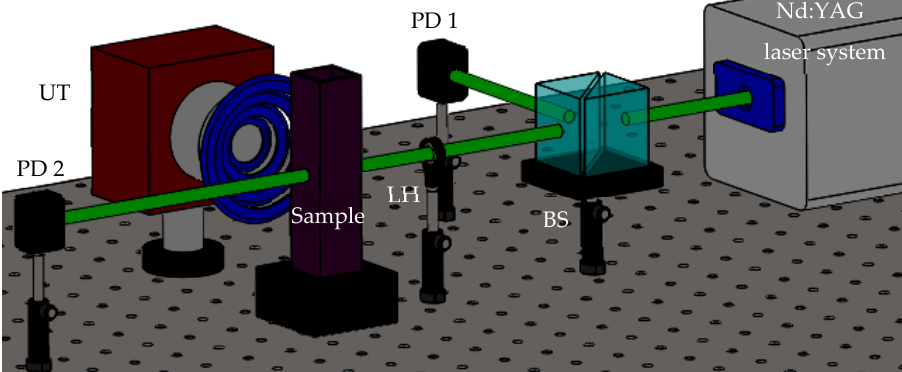
Figure 1. Experimental setup for single-beam transmittance measurements influenced by US.